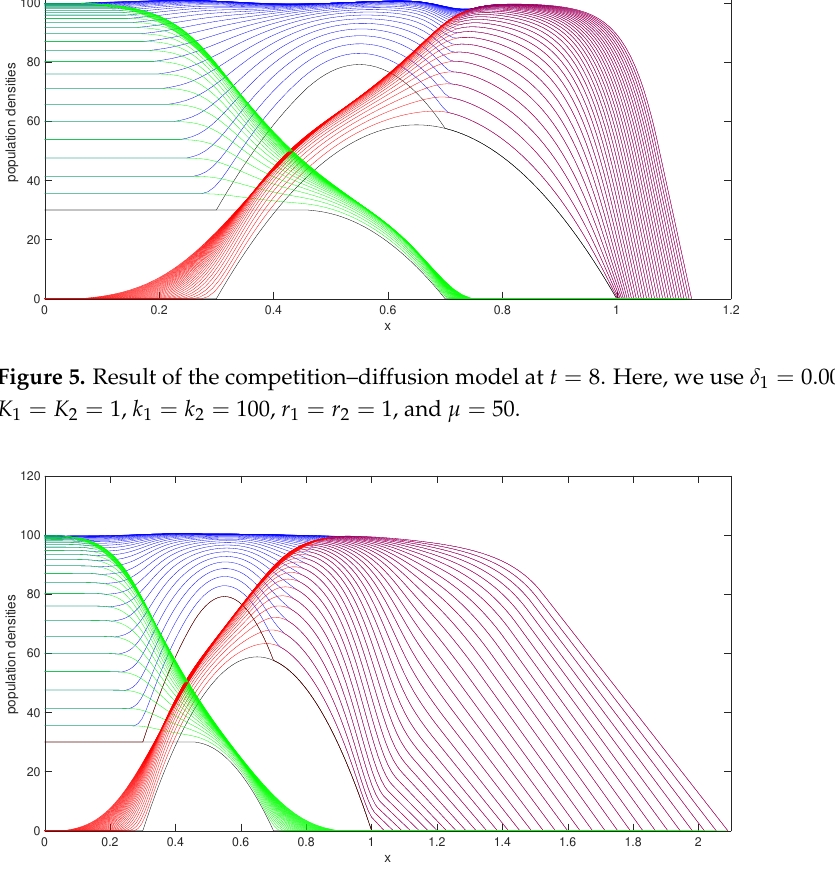
Figure 6. Result of the competition–diffusion model at t = 10. Here, we use δ 1 = δ 2 = 0.001, K 1 = K 2 = 1, k 1 = k 2 = 100, r 1 = r 2 = 1, and µ = 1. Decreasing µ has caused the population to disperse more though the boundary and the velocity of the moving boundary is slightly increasing at earlier times and remains constant for the rest of the